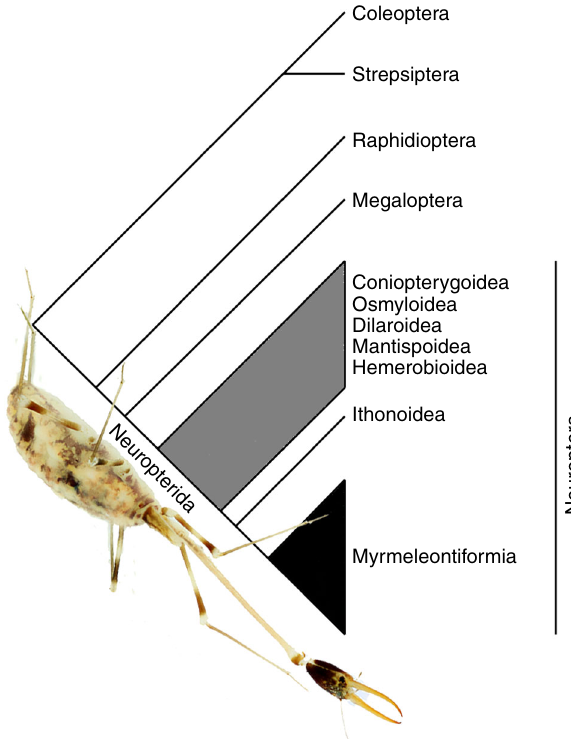
Fig. 2 Simpli fi ed cladogram of the internal relationships of Neuropteroidea. The larva of the nemopterid Pterocroce capillaris (Klug)